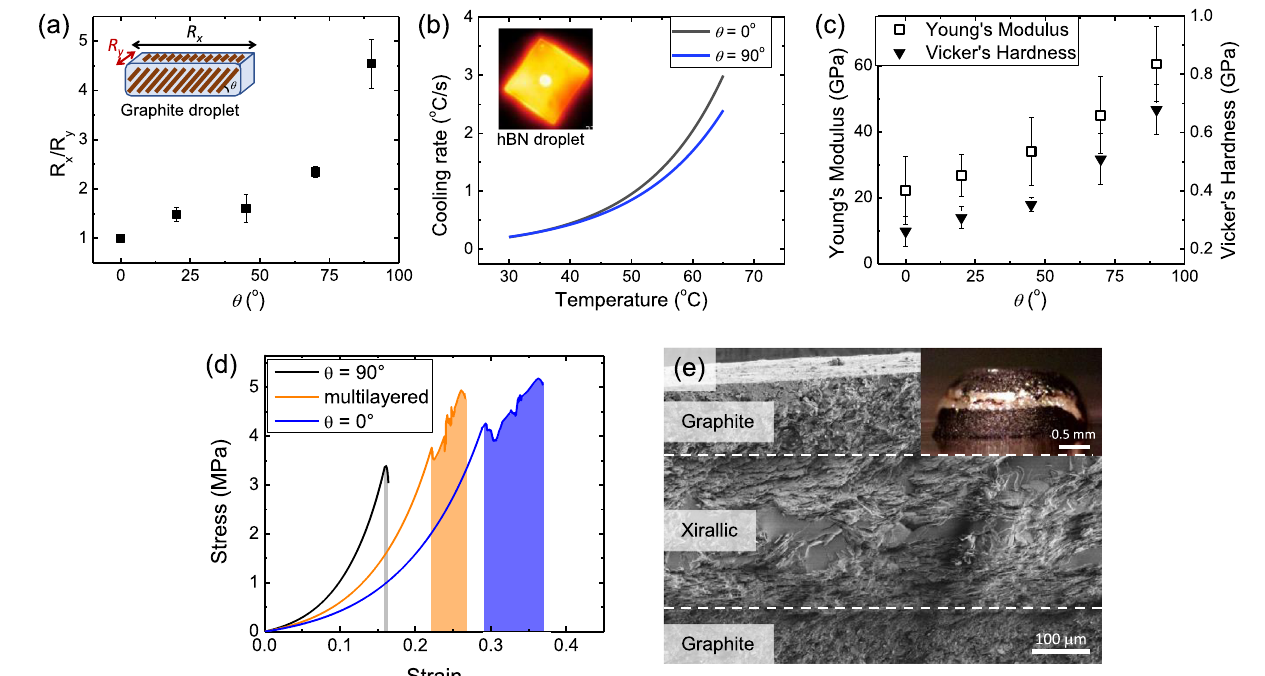
Fig. 5 | Multimaterial printing and microstructure-dependent properties. a Variation of the electrical resistance anisotropy R x = R y in graphite structures as a functionofmicroplateletangle θ .Insetshowsthedirectionsatwhich R x and R y were measuredrelativetotheplateletangle θ . b CoolingratesofhBNdropletsalignedat 0° (black) and 90° (blue). The insert shows a thermal image of a printed hBN droplet on a silicon wafer substrate, cooling down after being heated up to 70°C. c Variation of the Young ’ s modulus and Vicker ’ s hardness of sintered xirallic